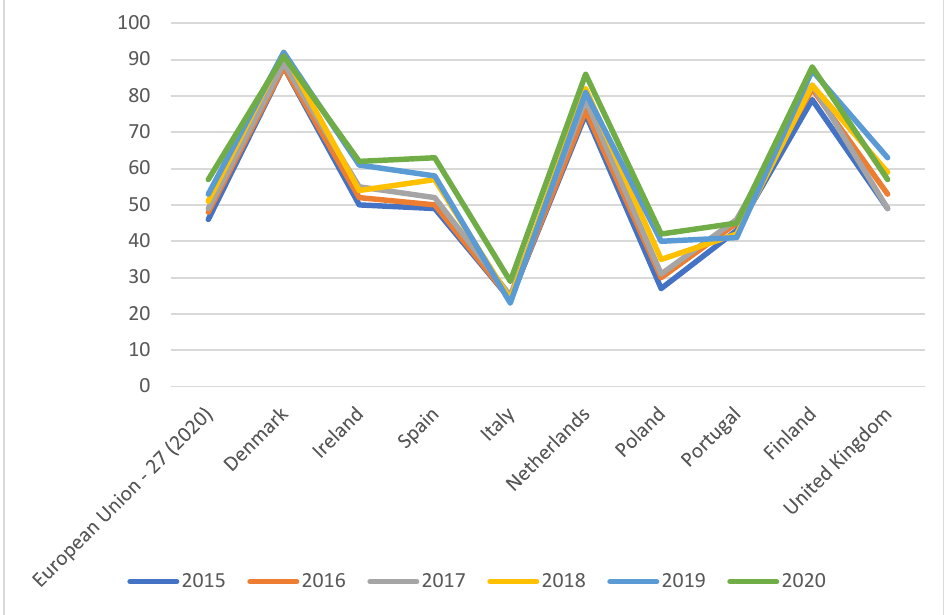
Figure 4. Internet use to interact with public services (% of individuals).